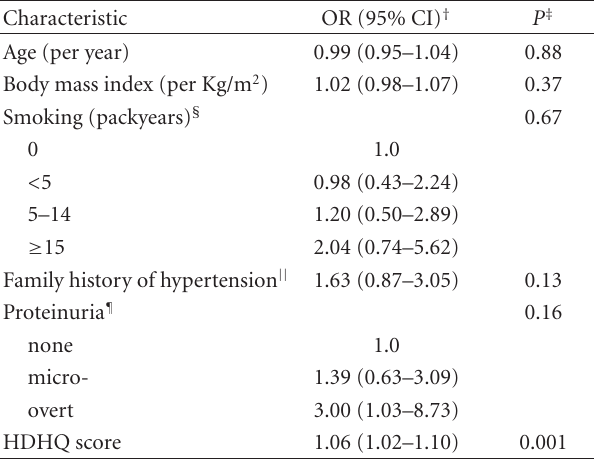
Table 4: Six-year incidence of hypertension ∗ by baseline character- istics: multivariate